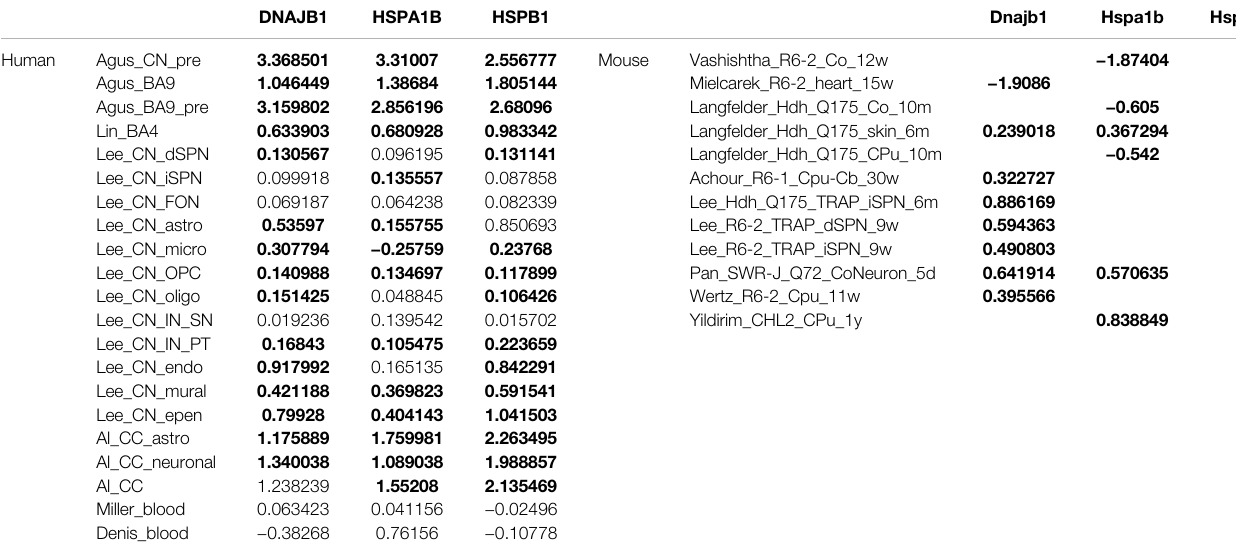
TABLE4| Logfoldchange(LFC)ofdifferentiallyexpressedgene(DEG),DNAJB1,HSPA1BandHSPB1inhumanandmouseprimarytissuedatasets.Thetablesummarized Log2 fold changes of the three most commonly dysregulated genes in postmortem brain across human and mouse primary tissue datasets. Note that the differentially expressed genes are bolded (Vashishtha et al., 2013; Mielcarek et al., 2014; Achour et al., 2015; Ring et al., 2015; Langfelder et al., 2016; Lin et al., 2016; Miller et al., 2016; Consortium,2017;Limet al.,2017;Mehtaet al.,2018;Panetal.,2018;Switonskaet al.,2018;Agusetal.,2019;Denisetal.,2019;Ooietal.,2019;Osipovitchetal.,2019; Yildirim et al., 2019; Al-Dalahmah et al., 2020; Lee et al., 2020; Smith-Geater et al., 2020; Wertz et al.,